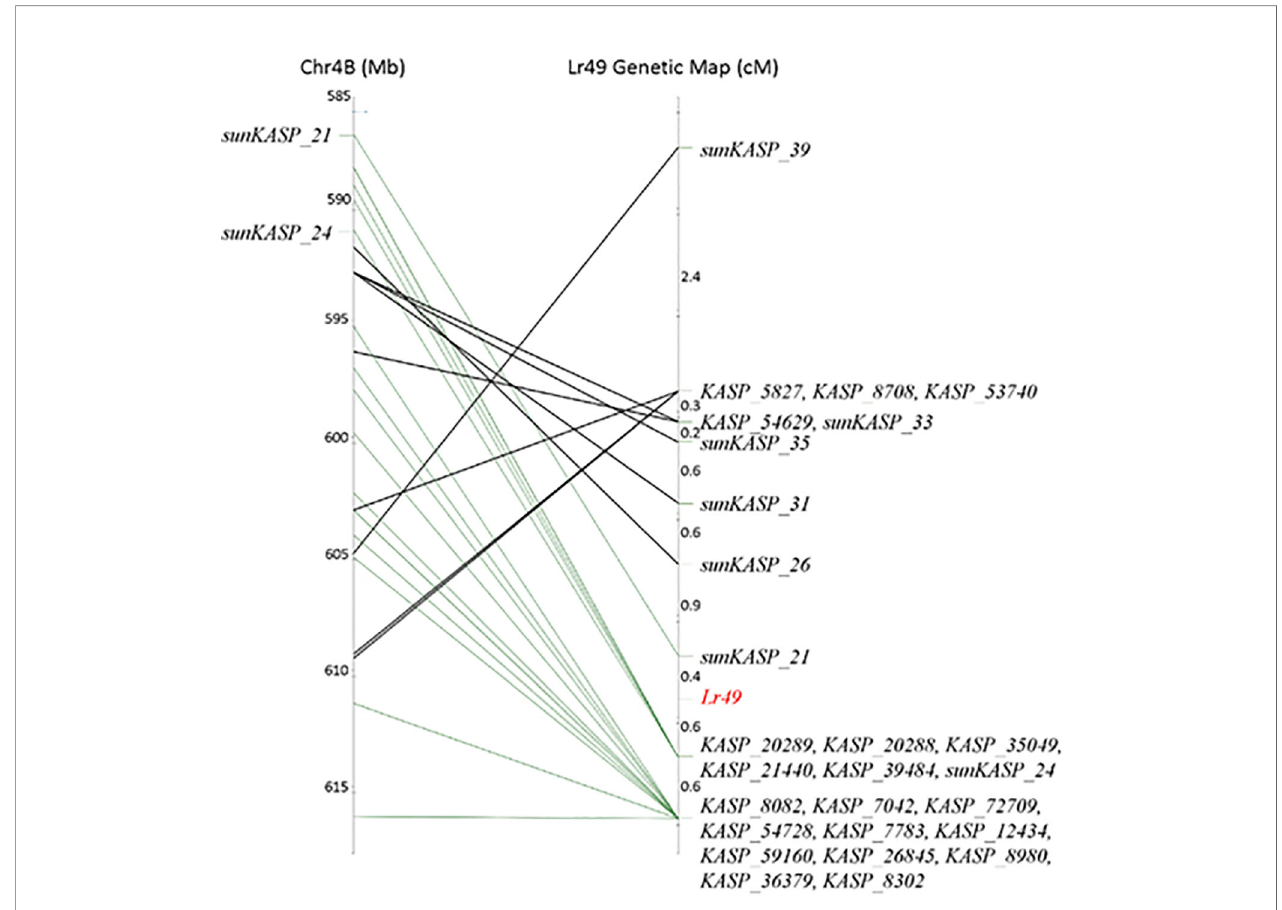
FIGURE 3 | Comparison of Lr49 genetic linkage map with the 585 to 617 Mbp interval of Chinese Spring chromosome 4B physical map using Pretzel, a genetic map viewing software (http://plantinformatics.io). Markers distal to sunKASP _26 are colinear with the physical map (green connections). The genetic map order of markers proximal to sunKASP _21 does not re fl ect the physical map order in Chinese Spring (black